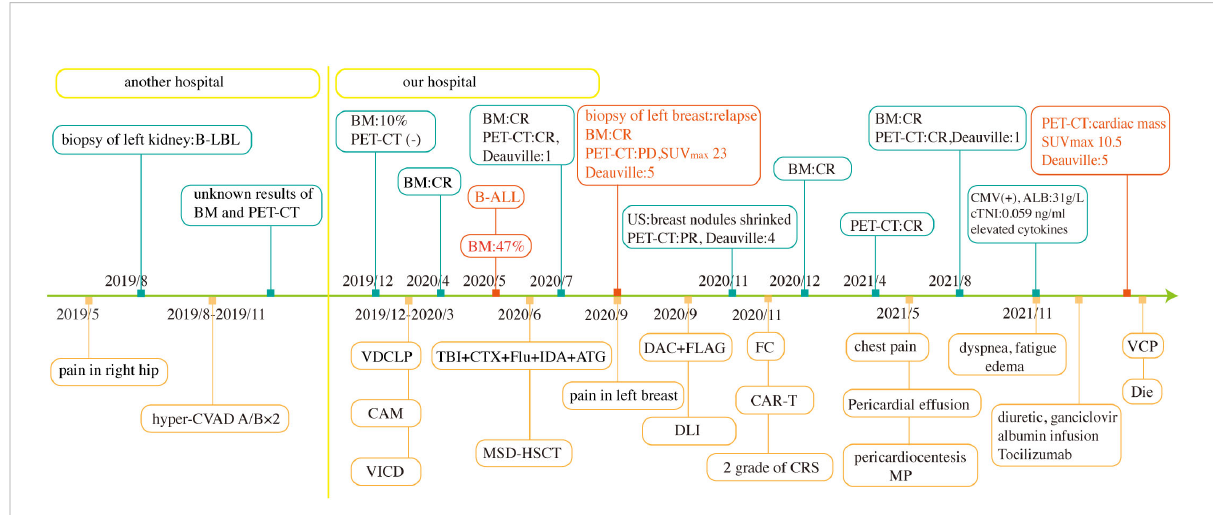
FIGURE 3 Clinical course of the patient. TBI+CTX+Flu+IDA+ATG, total body irradiation, cyclophosphamide, fl udarabine, idarubicin, and antithymocyte globulin. BM, bone marrow aspirate; US, ultrasound; MP,